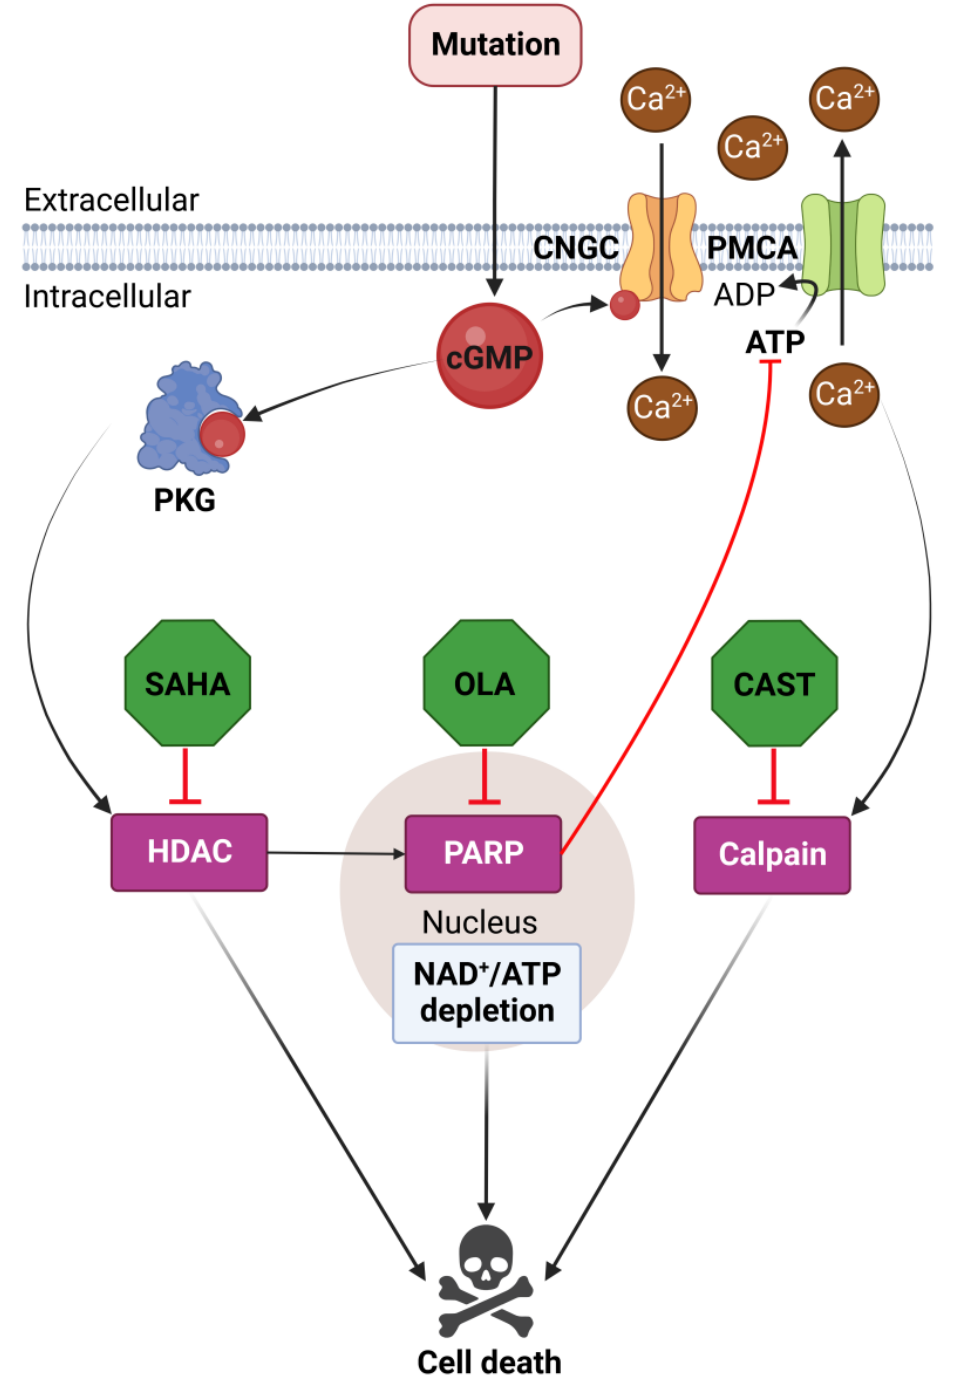
Figure 5. Molecular interactions between HDAC, PARP, and calpain during rd1 retinal degeneration. In rd1 photoreceptors, the initial genetic defect produces an accumulation of cGMP, which may then activate the cyclic nucleotide gated channel (CNGC) and protein kinase G (PKG). PKG, possibly in concert with voltage changes produced by CNGC, activates histone deacetylase (HDAC) resulting in DNA damage. Poly (ADP-ribose) polymerase (PARP) may attempt to repair such DNA damage, entailing a depletion of NAD + and ATP. Since ATP is required for plasma membrane Ca 2+ ATPase (PMCA)-mediated Ca 2+ extrusion, loss of ATP leads to increased intracellular Ca 2+ levels and excessive activation of calpain-type proteases. Eventually, the processes triggered by HDAC, PARP, and calpain activities result in photoreceptor cell